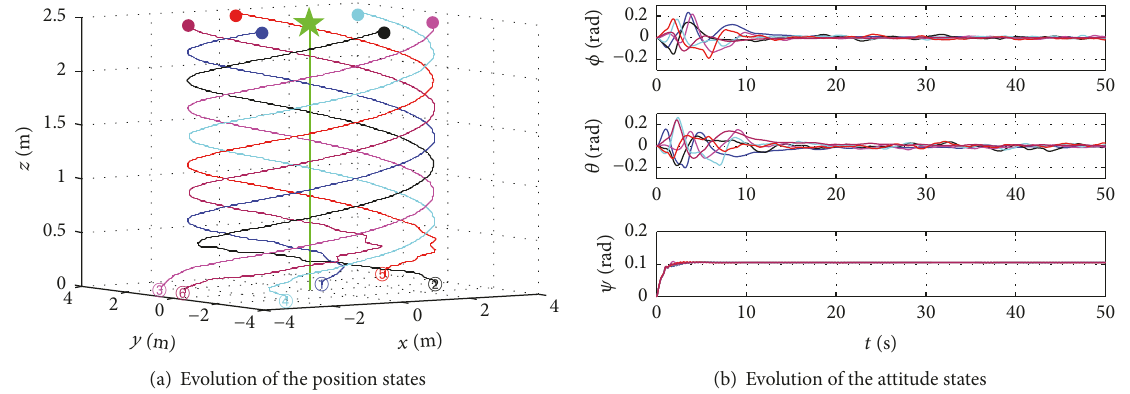
Figure 7: Trajectories of the agents within 50 s in Case 2.